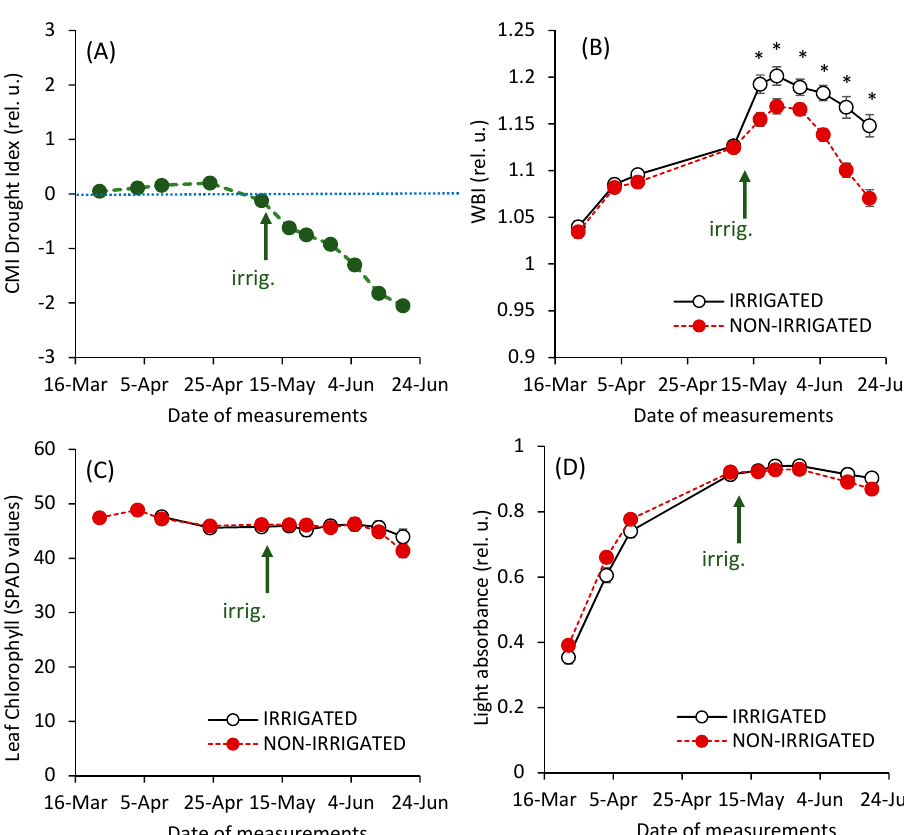
Figure 1. ( A ) Crop moisture index (CMI) drought index for non-irrigated variant, based on weather and soil observations during the spring vegetation period of wheat; ( B – D ) The trends of the indicators of the plant and canopy status measured at the leaf and canopy level during the spring vegetation season of wheat: ( B ) Water Band Index; ( C ) Leaf chlorophyll SPAD; and ( D ) light absorbance. The parameters were calculated using the records measured in wheat leaves in two variants of irrigation. The points represent the mean values ± standard error of 25 genotypes, 10 individuals per genotype ( n = 250). An asterisk indicates significant differences between non-irrigated and irrigated variants (Tukey HSD post hoc tests, p < 0.05).